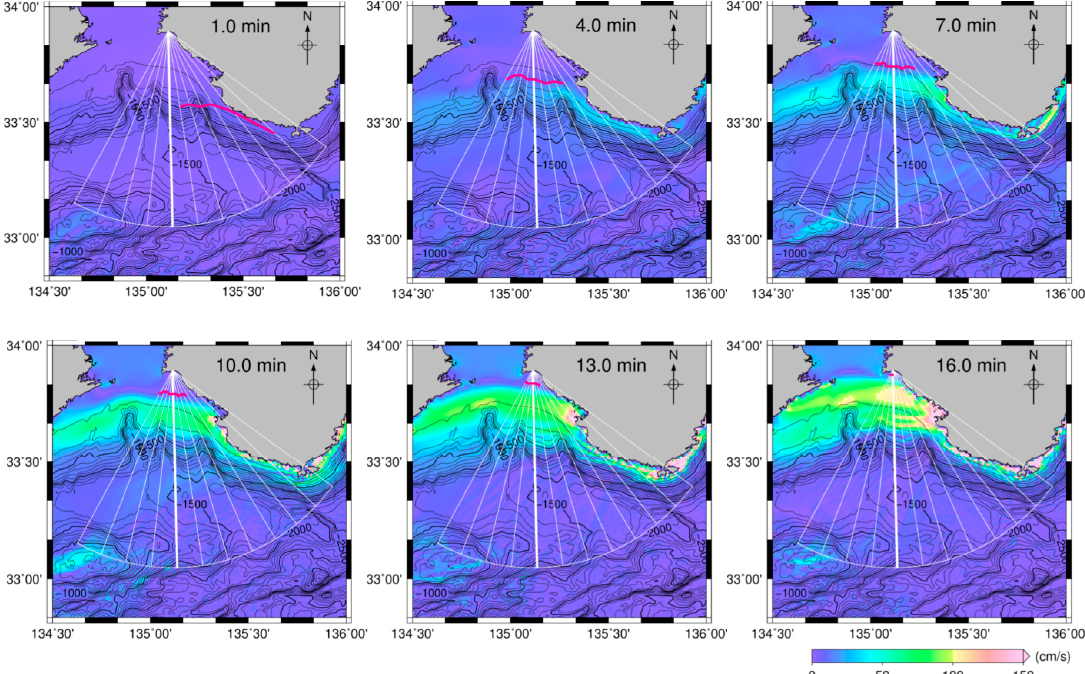
Figure 2. Simulated tsunami propagation within the Kii Channel at 1, 4, 7, 10, 13, and 16 min after tsunami occurrence. The pink line represents the first leading wavefront of the tsunami, defined as the range in which the sea surface slope along the beams calculated from the simulated tsunami heights first exceeds 0.0001.